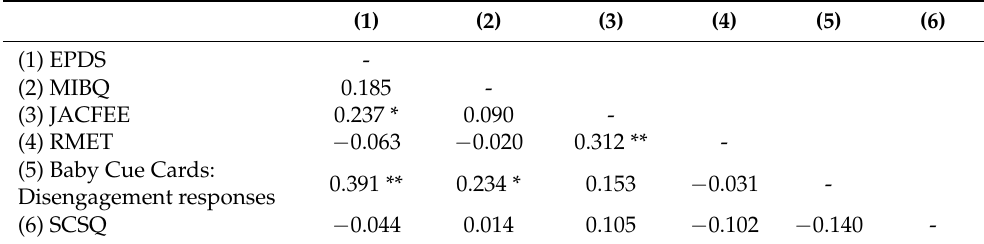
Table 3. Pearson’s correlations between the scores on the EPDS and MIBQ and on the social cognitive tests.